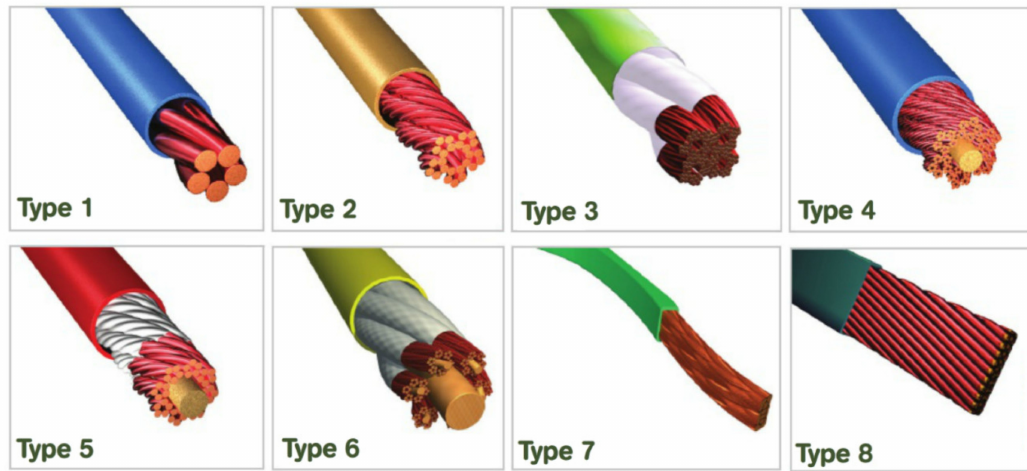
Figure 9. Different wire profiles for litz winding